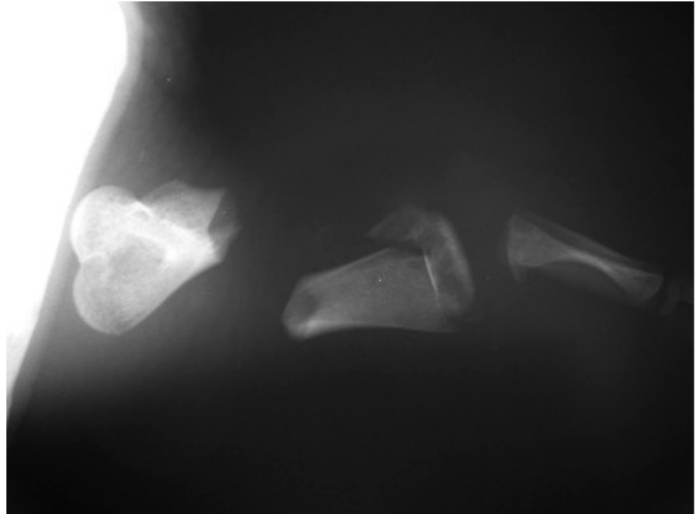
Figure 1. Caudocranial radiograph of the anterior right flipper showing transverse diaphyseal and the type II Salter-Harris fractures.